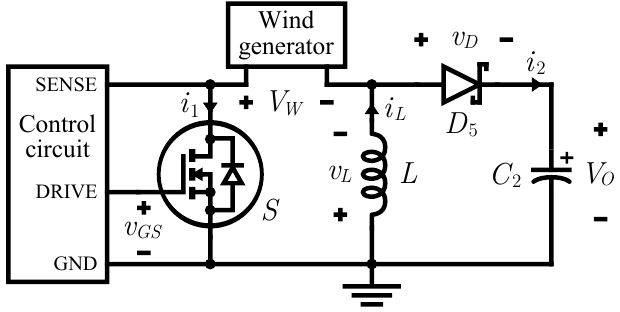
Figure 5. Circuit diagram of the considered buck-boost